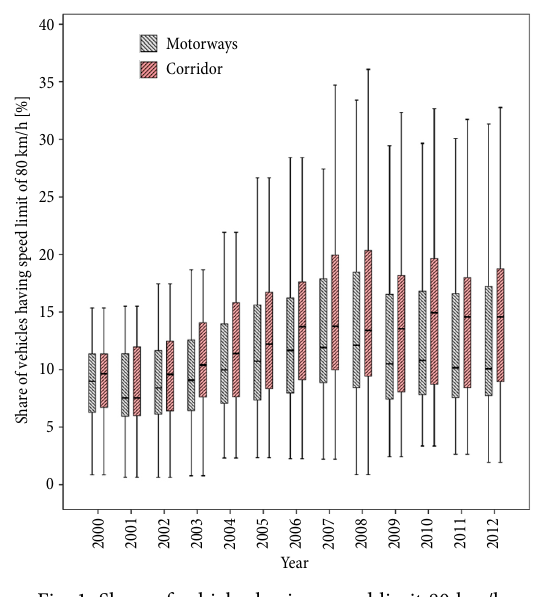
Fig. 1. Share of vehicles having speed limit 80 km/h on Slovenian motorways